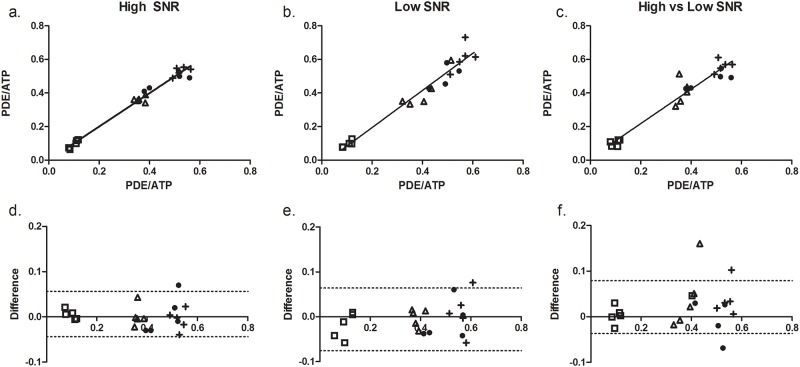
Intra class correlation coefficient between PDE-levels from the two repeated measurements and Bland-Altman plots of the difference in PDE-levels between the two repeated measurements for HH condition (a&d), the LL condition (b&e) and the HL condition (c&f).The five individual subjects are labelled with different symbols. Each symbol represents one individual muscle of an individual subject. The black line is the line of identity.